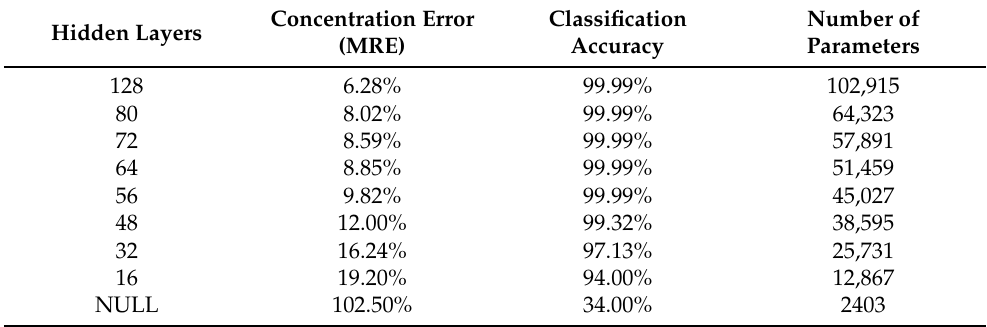
Table 1. CNN algorithm classification accuracy and concentration prediction accuracy under different hidden layer sizes. The value in the ’number of parameters’ column represents the number of parameters in the fully connected layer. Concentration Error Hidden Layers (MRE)